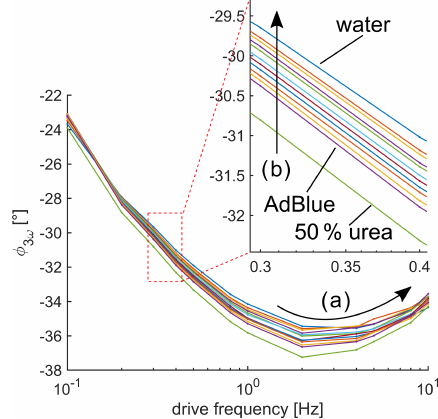
Figure 7. Phase φ as a function of drive frequency. (a) Phase φ 3 ω does not monotonically behave. However, the measured phase has a local minimum at 2Hz. (b) A correlation between phase and urea concentration can be found as indicated by the arrow. The phase increase for increasing urea concentration.